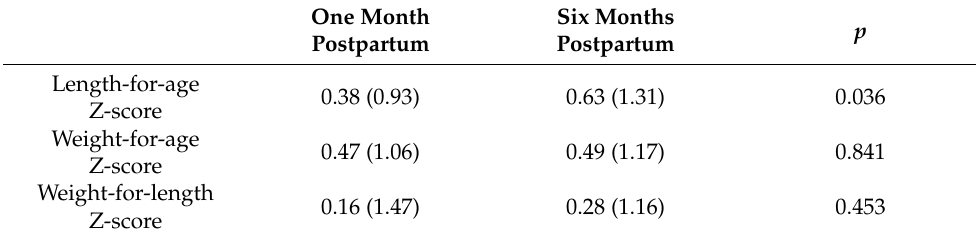
Values are presented as the means and standard deviations. Differences in Z-scores between surveys were analyzed by one-way repeated measures ANOVA